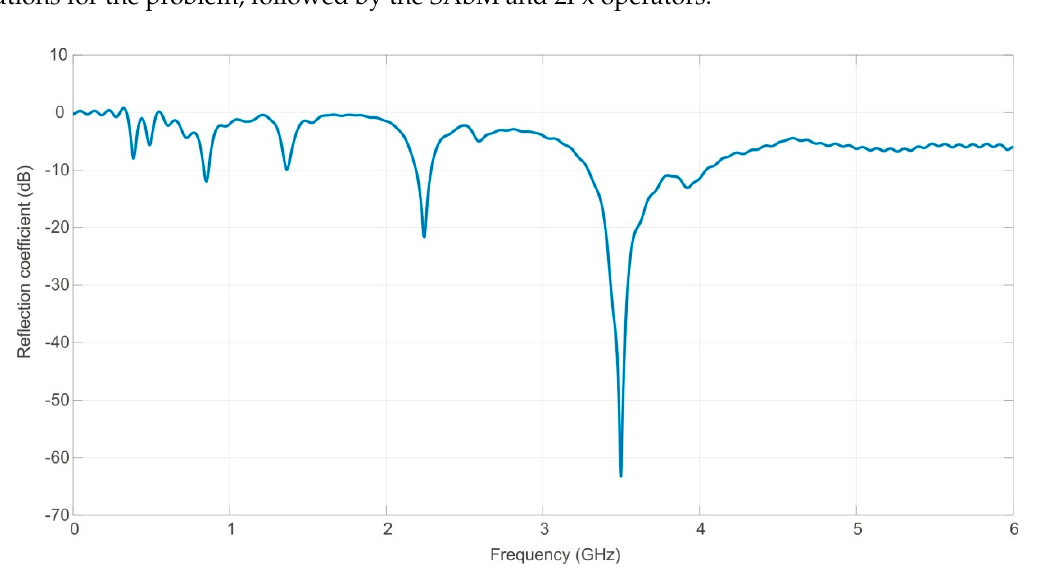
Figure 3. Reflection coefficient of the proposed antenna optimized for f 2 and f 3 frequency bands.